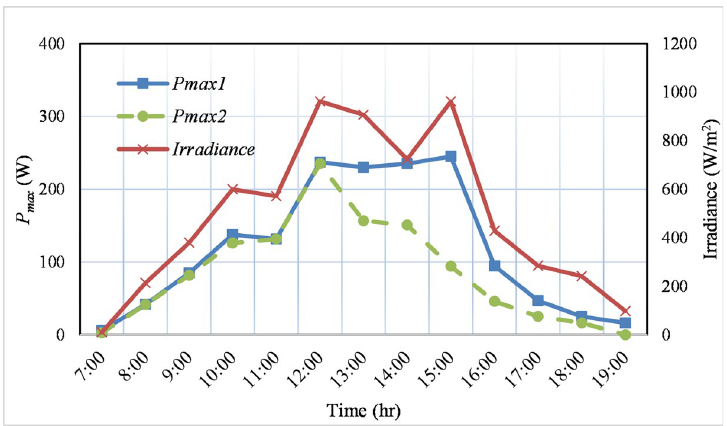
Fig 15. Maximum power of the two monocrystalline type PV panels and irradianceon a sunny day.